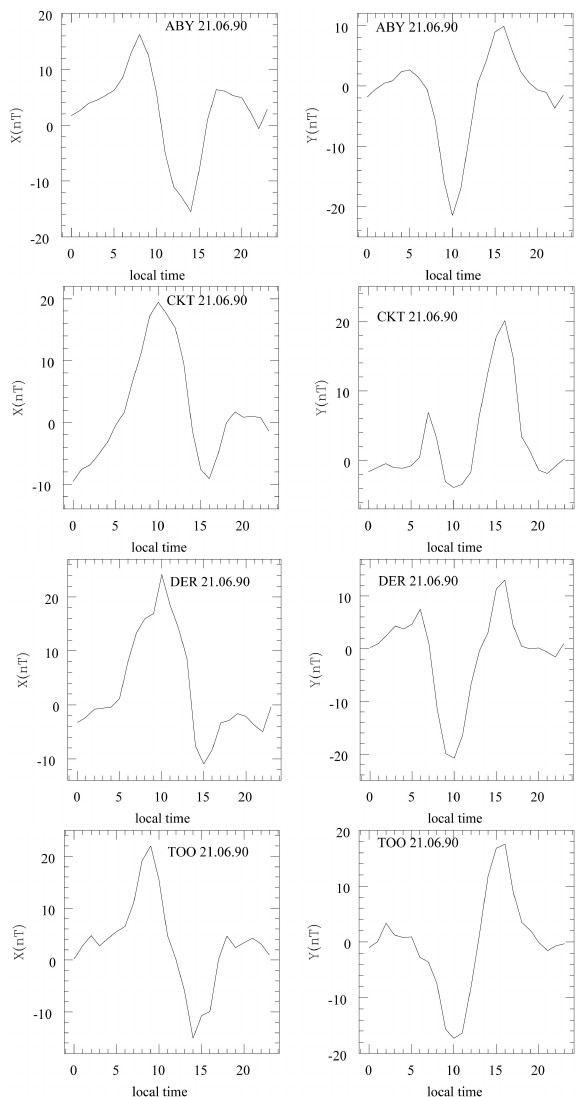
Fig. 3. As for Fig. 1 but at 03:00 and 05:00 UT on 2 June 1990. Ar- row lengths: 5 ◦ longitude length is equivalent to 22nT at 03:00 UT and to 25nT at 05:00